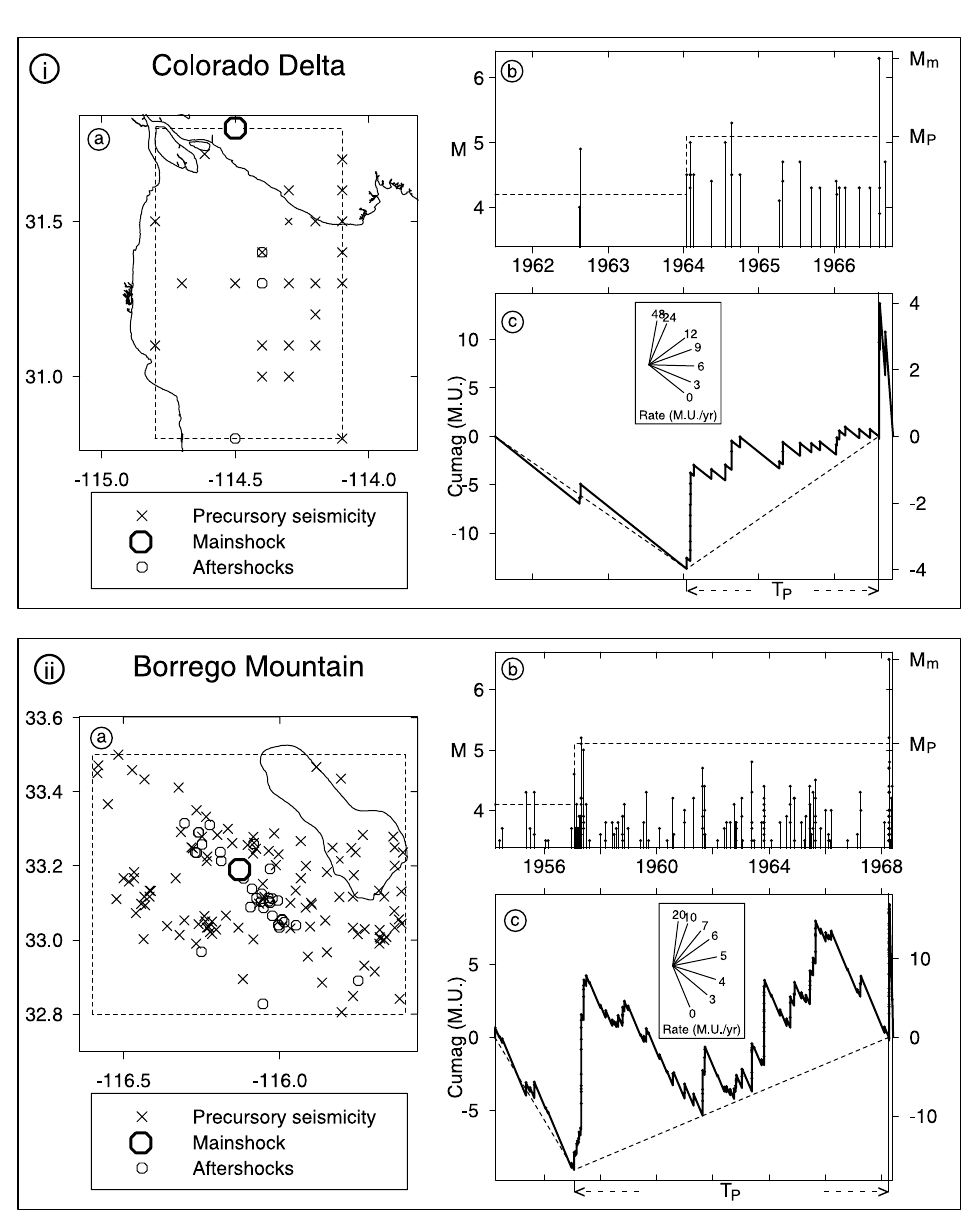
Fig. 3i,ii. (cid:115) -phenomenon: data and interpretation for major earthquakes at (i) Colorado Delta and (ii) Borrego Mt. Interpretation is explained in fig.1a-c. a) Epicentres. b) Magnitudes versus time, also showing (dashed lines) the derived prior and precursory magnitude levels. c) Cumag (eqs. (2.1), (2.2)), also showing (dashed lines) the derived prior and precursory seismicity rates. (The cumag scale on the right-hand side refers to the mainshock- aftershock